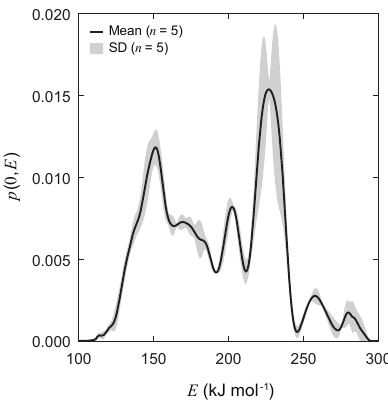
Figure 7. Regularized p( 0 ,E) distribution for Narayani POC. Mean (black line) and standard deviation (gray shaded region) of p( 0 ,E) analyzed using a range of G 0 and β values ( n = 5). Narrow standard deviation indicates that model results are independent of experimental conditions.